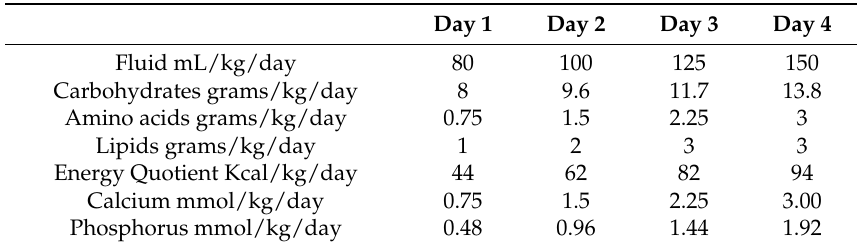
Table A1. Standard parenteral nutritional intake.